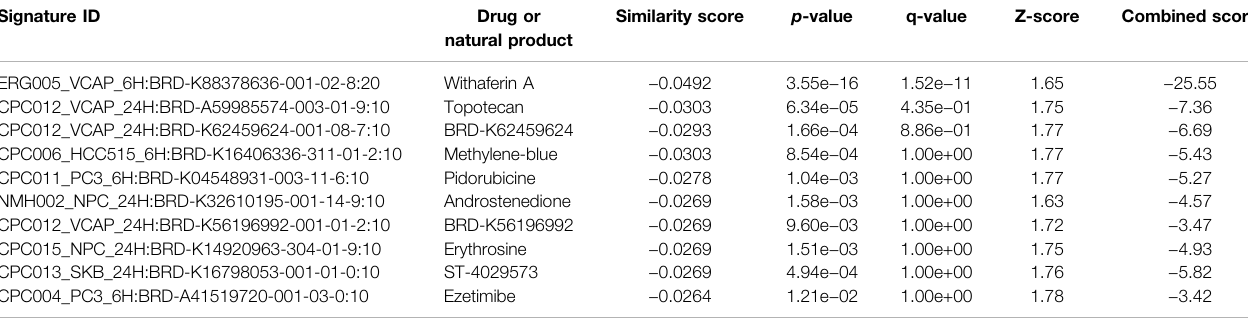
TABLE 7| Top small molecules withopposite molecular signaturesbasedon L1000FWD web-based tool forquerying geneexpression signatures (Neuro-COVID vs. IIH-Tc Meta) against signatures created from human cell lines treated with over 20,000 small molecules and drugs for the LINCS project.